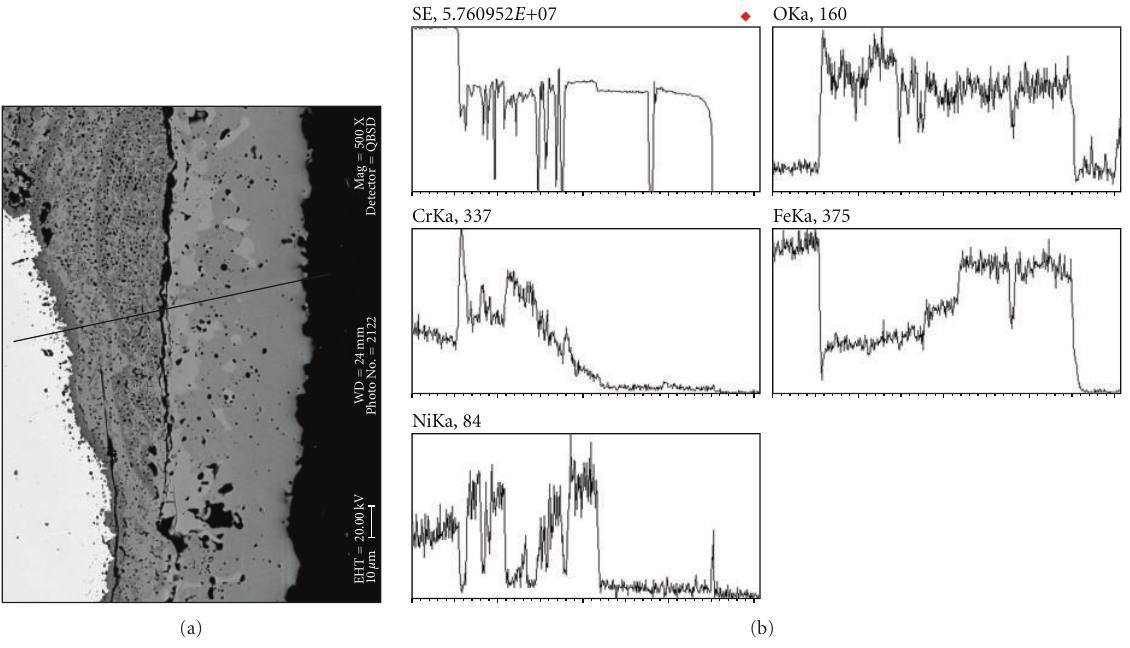
Figure 8: (a) SEM micrograph of the cross-section of the AISI 304 stainless steel oxidized at 1000 ◦ C for 100 hours and (b) XRD mapping analysis of the line